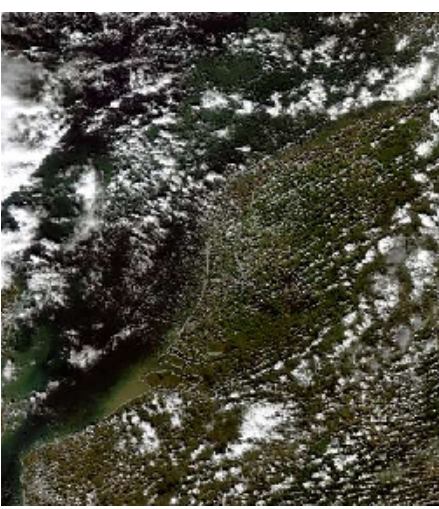
Figure 2. MODIS VIS satellite picture at the 24th of August 2010 1221 UTC.